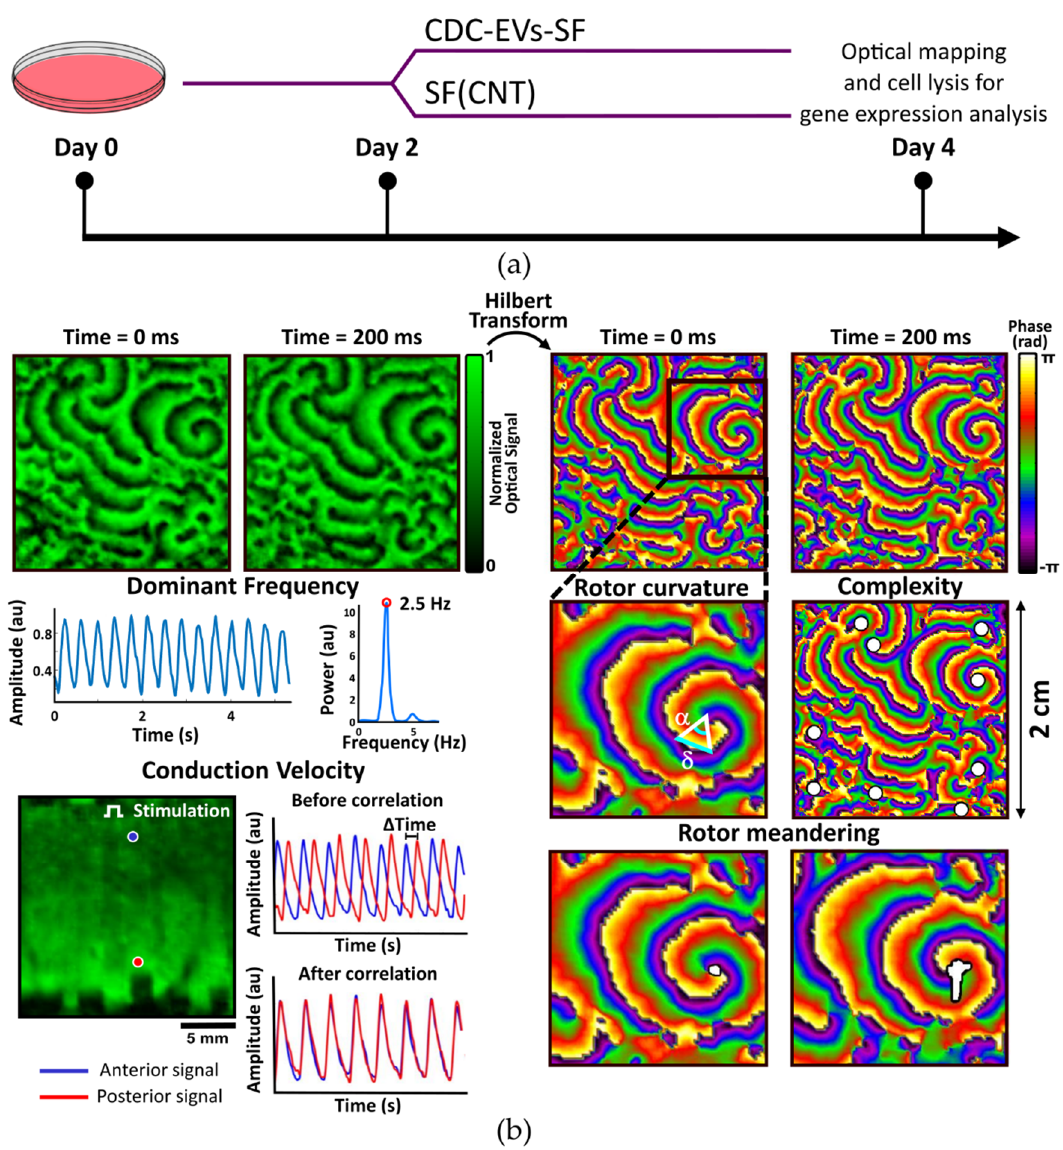
Figure 2. Experimental protocol and methodology employed for calcium transient (CaT) recording analysis: ( a ) experimental set-up consisting of cell seeding at day 0, Claycomb medium without FBS (serum-free (SF)) and with addition of EVs in CDC-EV group at day 2, and optical mapping and cell lysis for later RNA extraction at day 4; ( b ) example of optical mapping recording analysis. Two snapshots of optical mapping recordings are shown at 0 and 200 ms (upper left), as well as their phase maps, obtained by applying Hilbert transform (upper right). Example of the optical mapping signal for a specific pixel and its corresponding power spectrum, with the peak marking the dominant frequency, are shown (middle left). For conduction velocity (CV) (lower left), the culture is divided into delimited areas, and two pixels are selected (with their corresponding optical mapping signals). Correlation of these signals gives the time elapsed (∆t) between the activation of the two points. CV is calculated as the ratio between the physical distance between the two points and the time elapsed. Rotor curvature, complexity, and meandering calculated from phase maps are represented. Rotor curvature was determined from the derivative of the relative angle (α) over the relative distance (δ) in lines from the rotor tip to 2π (middle right). For complexity, phase singularities (PSs) were identified and quantified in a certain area (middle right). In rotor meandering, from the phase map, the path followed by the tip was traced and quantified (lower right).